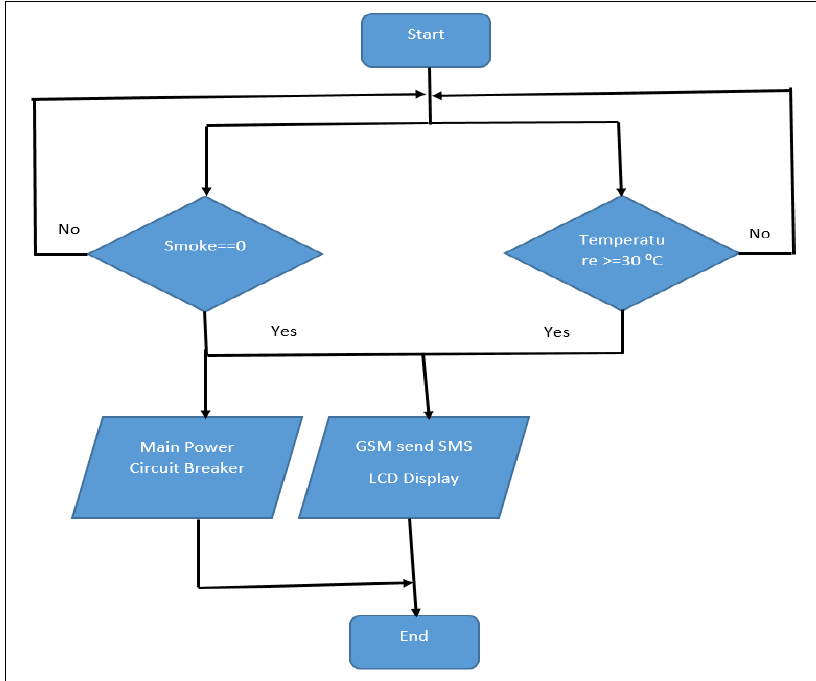
Figure 6: Flowchart of the smoke and temperature